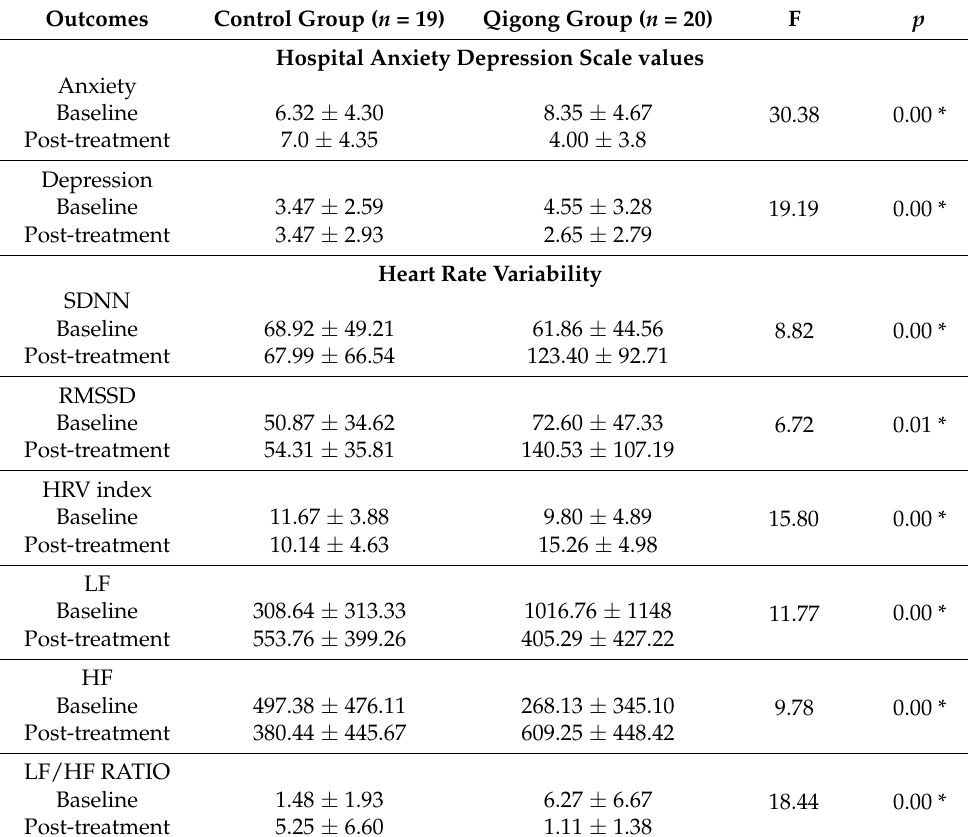
Table 2. Before- and after-treatment comparison between the